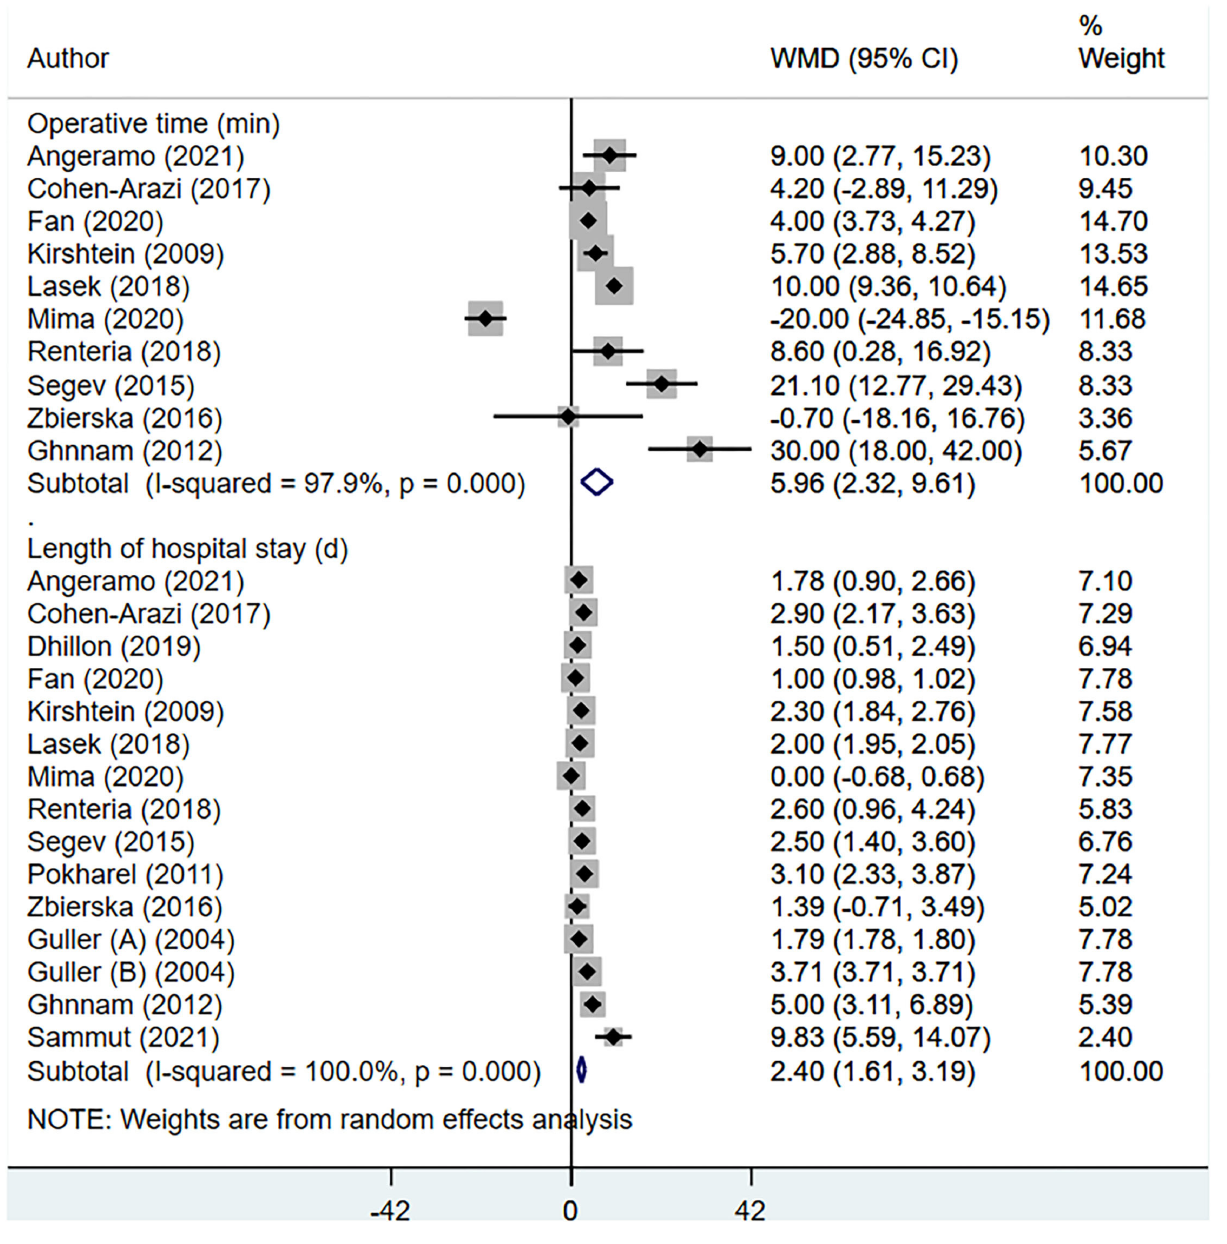
increased risk of complicated appendicitis (perforation,